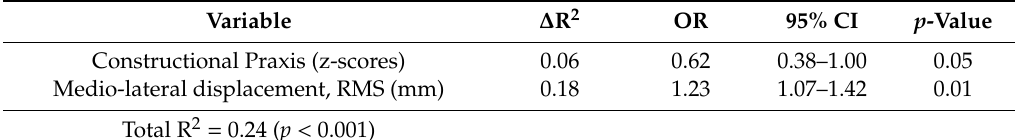
Table 4. Results of the multivariate regression analysis to predict in-hospital